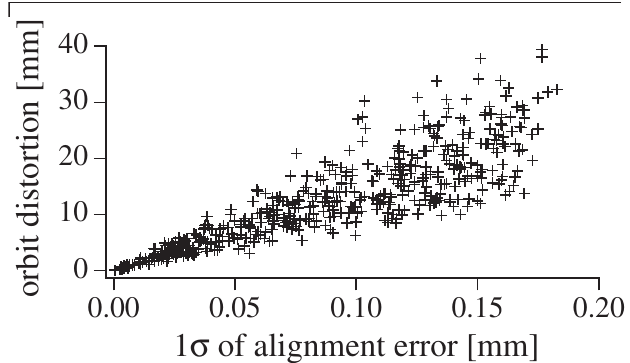
FIG. 3. Distribution of maximum horizontal orbit distortion out of 501 different alignment